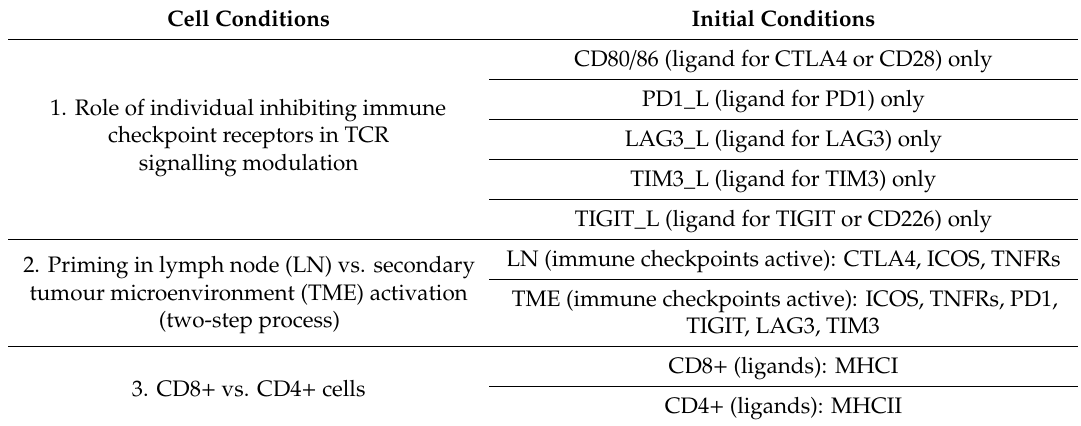
Table 1. Definition of cell conditions: the nodes of the model listed in this column inform on which of these components are initially active (set to 1), and these initial conditions correspond to cell environmental conditions, cell localization, or cell types. PD1: programmed cell death protein